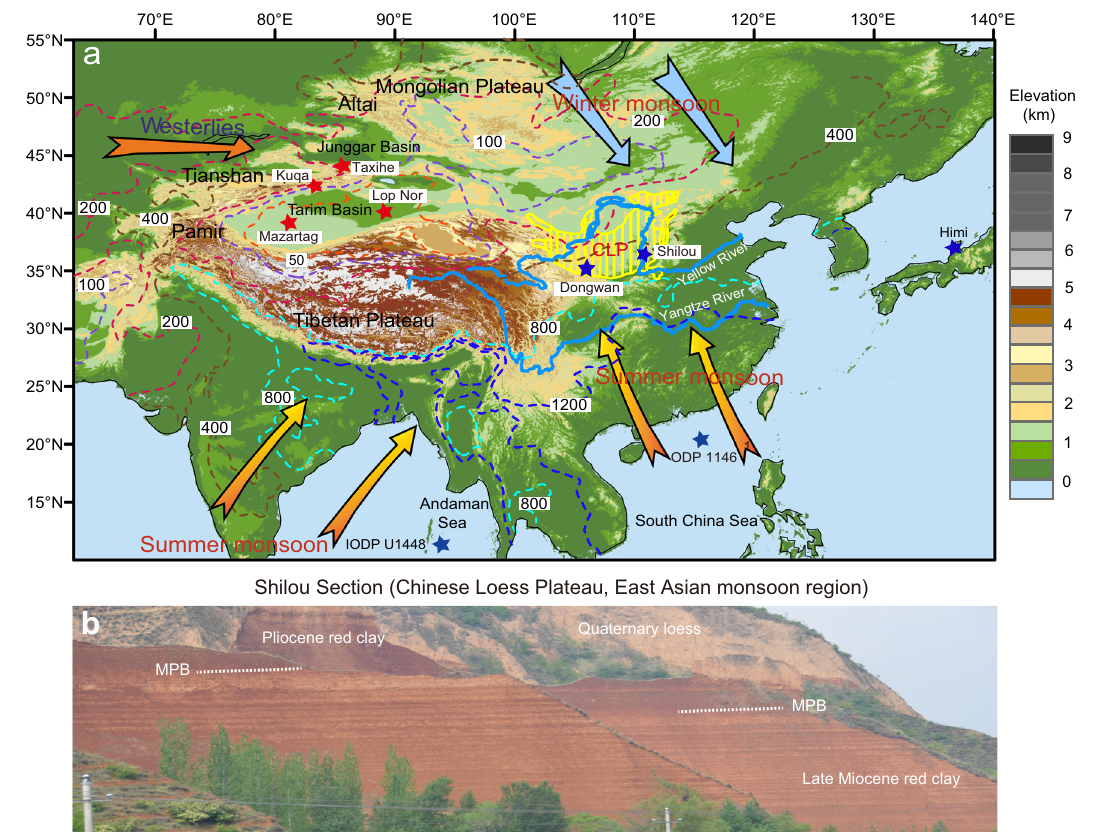
Fig. 1 Site location map and fi eld photograph. a Topographic map of Asia with important geographic landmarks mentioned herein. Dominant winds and mean annual precipitation (mm, 1979 to 2007 average) are shown as arrows and dashed contour lines, respectively. Red and blue stars mark locations that shifted to drier and wetter conditions across the Miocene – Pliocene boundary (MPB), respectively. South and East Asia receive high Asian summer monsoon precipitation. Central Asia is a low precipitation region that is in fl uenced mostly by the Westerlies. b Field photograph (taken by H. Ao) of the Shilou red clay sequence (with horizontal bedding) from the eastern Chinese Loess Plateau (CLP, monsoonal region). The upper sequence (Pliocene) has a more saturated red colour than the lower part (late Miocene), which is consistent with enhanced pedogenesis and increased summer monsoon precipitation across the